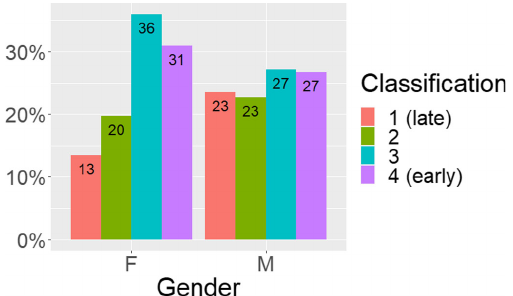
FIG. 7. The percent of females (F) and males (M) in each completion time classification. For example, 13% of females are in class 1.